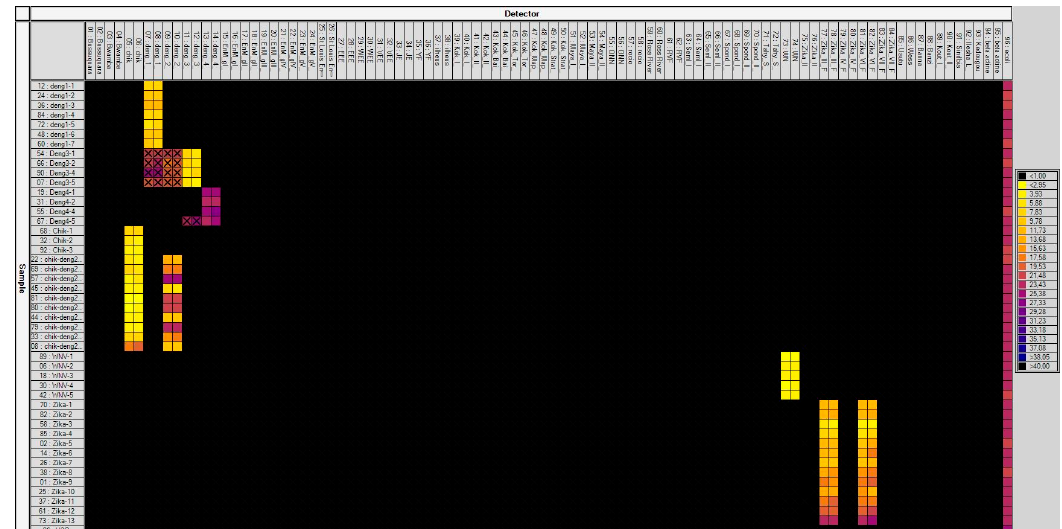
Figure 2. Screening of artificially infected mosquitoes through the BioMark TM dynamic array system developed (96.96 chip). Each square corresponds to a single real-time PCR reaction, where rows indicate the batches of mosquitoes tested and columns represent the targets of each primer/probe set. Crosses indicate cross-reaction of assays. C t values for each reaction are indicated in color; the corresponding color scale is presented in the legend on the right. The darkest shade of blue and black squares are considered as negative reactions with C t > 30. chik: Chikungunya; deng: Dengue; EnM: Murray Encephalitis; St Louis Enc: Saint Louis Encephalitis; EEE: Eastern Equine Encephalitis virus; WEE: Western Equine Encephalitis; VEE: Venezuelan Equine Encephalitis; JE: Japanese Encephalitis; YF: Yellow fever; Kok: Kokobera grou ; Maya: Mayaro; ONN: O’nyong nyong; RVF: Rift Valley Fever; Seml: Semliki fores ; Spond: Spondweni; Tahy: Tahyna; WN: West Nile; Wess: Wesselsbron; Kout: Koutango.